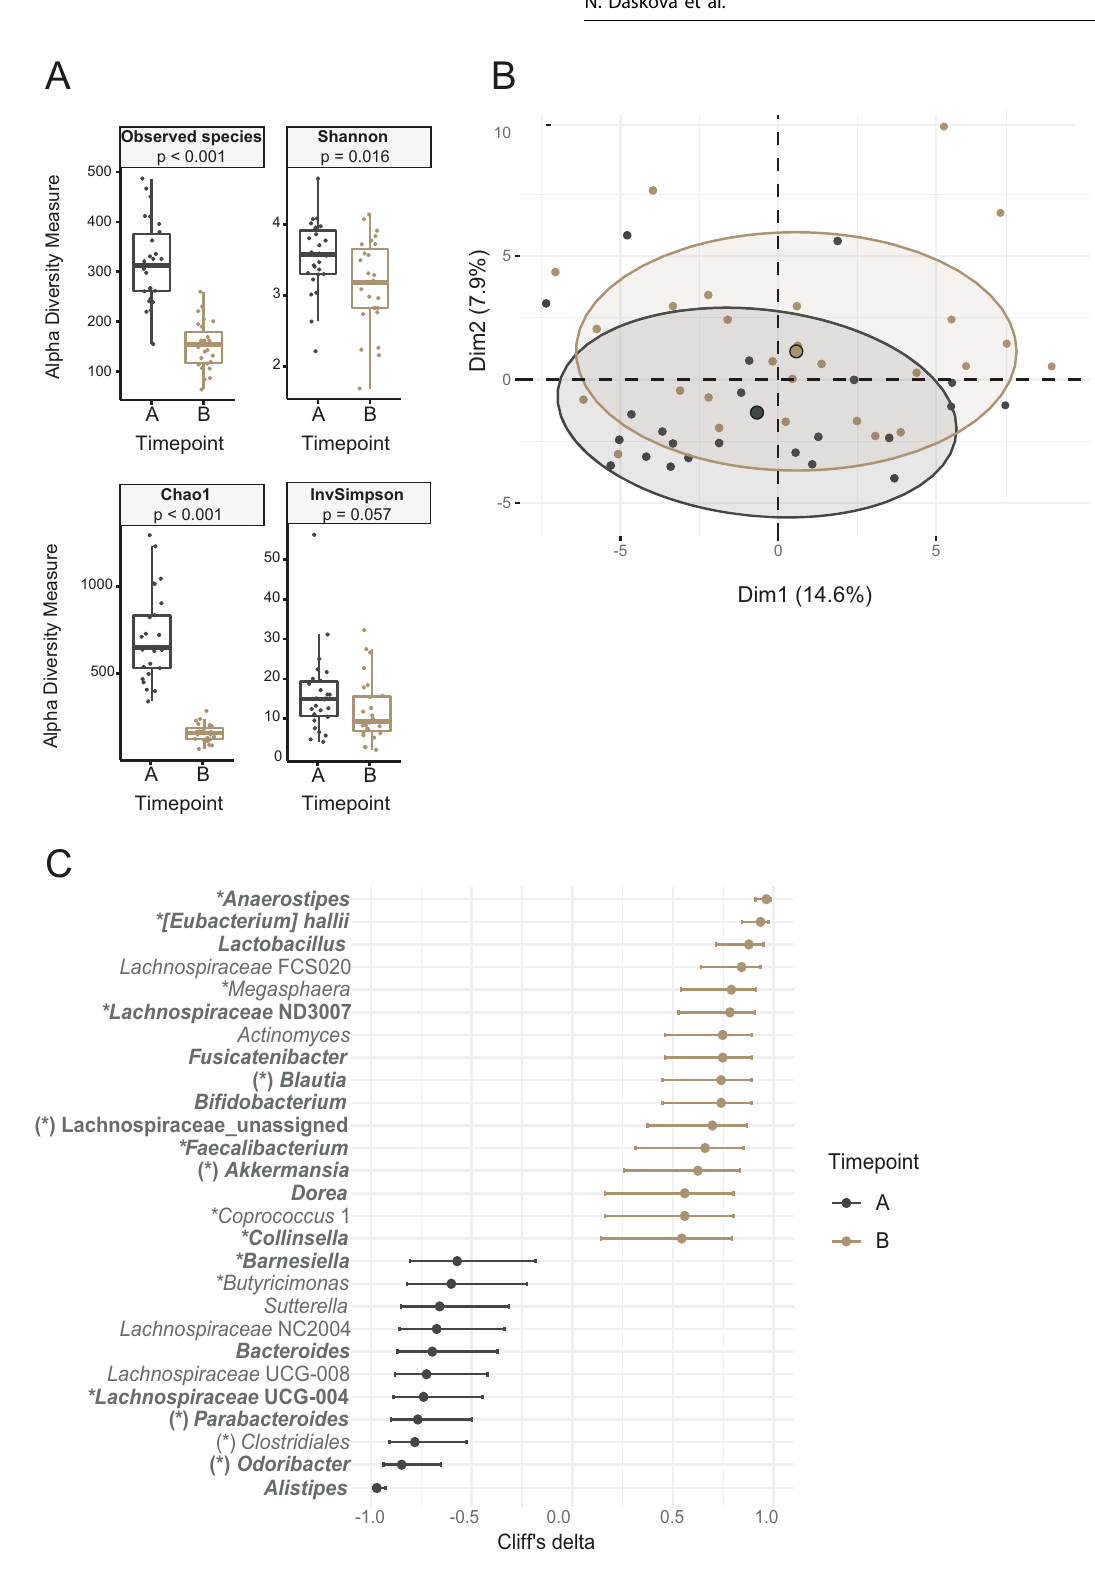
Fig. 5 Effect of inulin on fecal microbiome composition. A Alpha diversity calculated on rare fi ed ASV data, p value represents the result of Wilcoxon test; B 2D PCA scores plot on genera level. The explained variance of each component is included in the axis labels. The large points represent the centroids of each group. C Biomarker bacterial genera. Prior to all calculations, data were clr transformed. Biomarkers were generated from univariable discriminant analysis (FDR ≥ 0.1), with effect size estimated by Cliff ’ s delta with a 95% con fi dence interval. A, time point prior to intervention; B, time point post-intervention. Core genera (bold) are de fi ned by the condition abundance >0.05% and prevalence >75% at least in one group. Genera marked by * are con fi rmed butyrate producers, and genera marked by (*) are potential butyrate producers. ASV, amplicon sequence